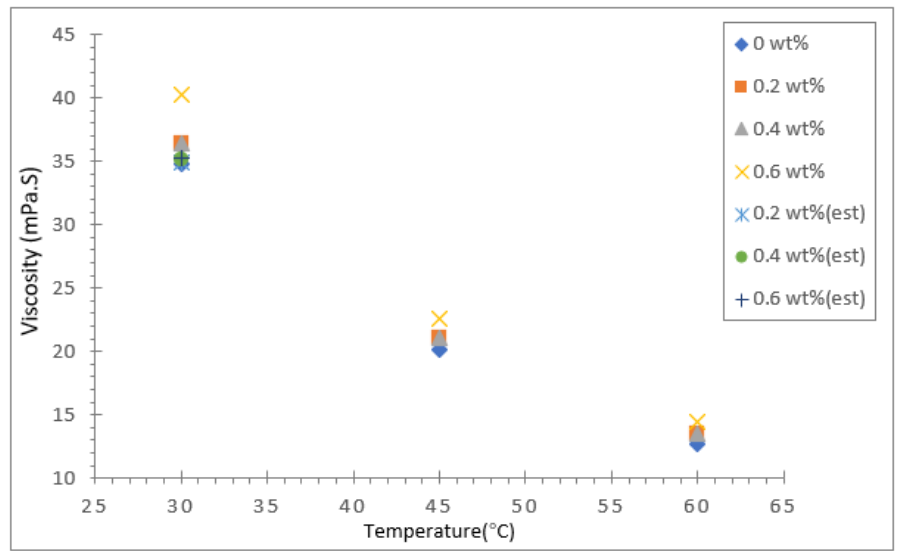
Figure 9. Dynamic viscosity of coconut oil/Al 2 O 3 -TiO 2. hybrid nanofluid.